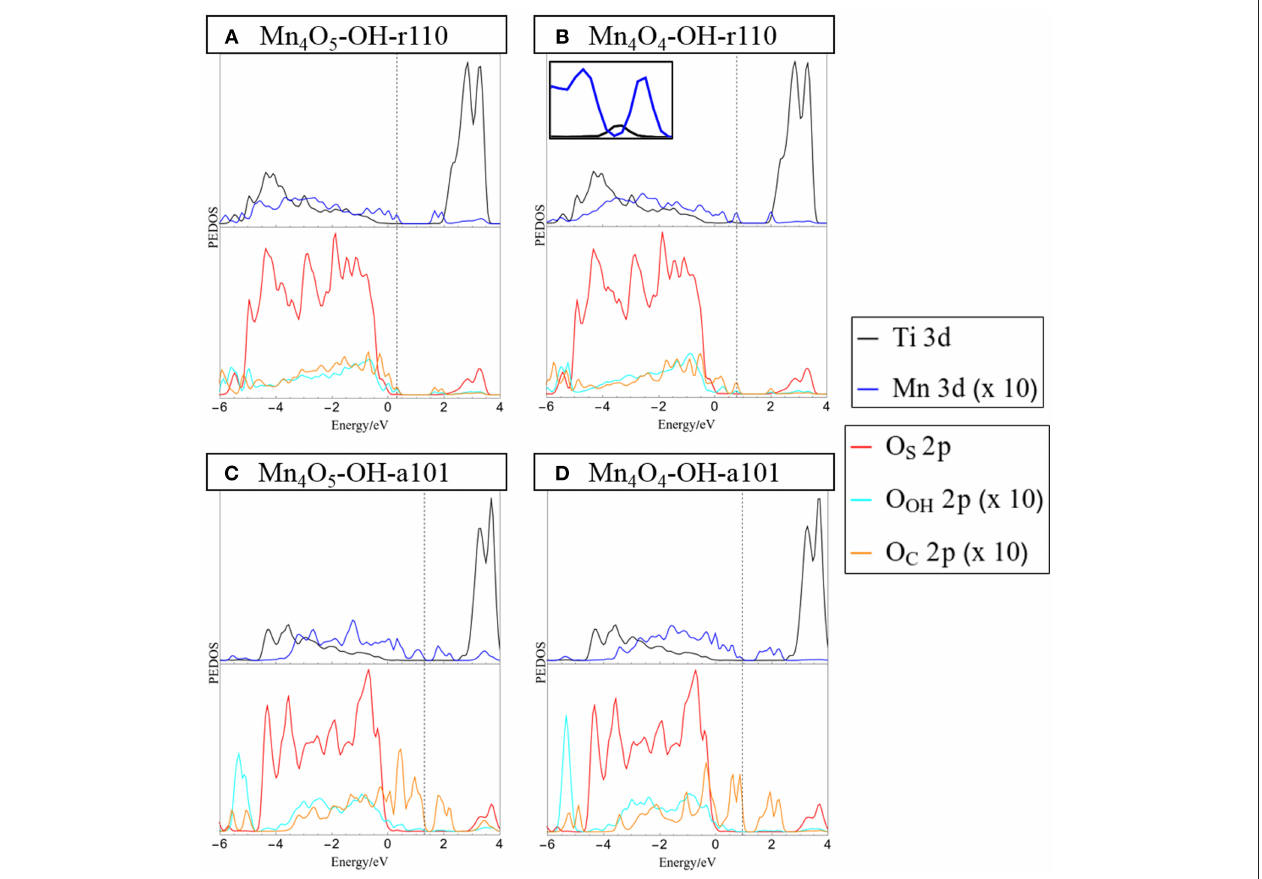
FIGURE 2 | Projected electronic density of states (PEDOS) plots for (A) Mn 4 O 5 -, and (B) Mn 4 O 4 -OH-r110 and (C) Mn 4 O 5 -, and (D) Mn 4 O 4 -OH-a101. The computed valence band max is set to 0eV and the Fermi energy is indicated with a dashed line. The top half of each panel displays Ti and Mn 3d derived states. The bottom halves of the panels show contributions to the DOS from oxygen 2p states of the surface (O C ), surface bound hydroxyls (O OH ) and nanocluster (O C ). Inset in panel (B) shows the mid-gap occupied Ti 3d states in the range [0eV, 1eV].